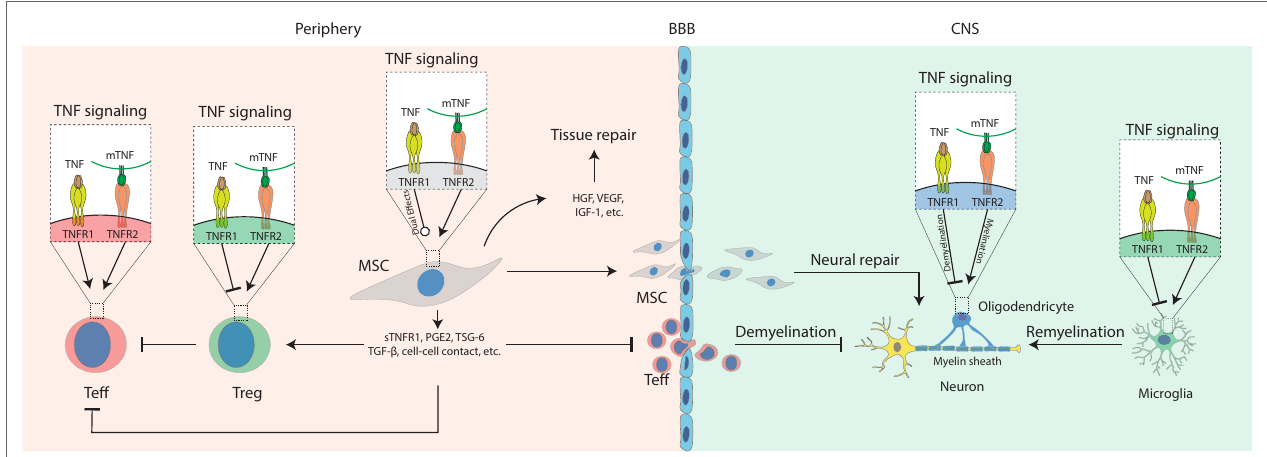
FiGURe 1 | Schematic diagram for the role of tumor necrosis factor (TNF) signaling in mesenchymal stem cell (MSC)-based therapy on autoimmune and inflammatory diseases. Under inflammatory conditions, TNF binds TNFR1 to activate T effector (Teff) cells while impairing regulatory T cells (Tregs); mTNF mostly binds TNFR2 to activate Teff cells and also activate Tregs to mediate their immunosuppressive effects in the periphery. In the central nervous system (CNS), TNFR1 signaling induces cytotoxic effects on oligodendrocytes resulting in neural demyelination and activates microglia to produce pro-inflammatory molecules such as TNF. TNFR2 signaling protects the survival of oligodendrocyte and microglia and promotes myelin clearance and remyelination mediated by microglia. In addition, TNFR1 or -R2 signaling can enhance the immunosuppressive effects of MSCs to alleviate autoimmune and inflammatory diseases. Compared to non-primed controls, TNF-primed MSC produce more soluble TNFR1 (sTNFR1), PGE2, TSG-6, and TGF- β , enhance Treg functions, neutralize TNF via sTNFR, prevent Teff cell infiltration into the CNS, release growth factors such as hepatocyte growth factor (HGF), insulin-like growth factor-1 (IGF-1), and VEGF to promote tissue or neural repair, infiltrate the CNS to mediate neural protection by regulating oligodendrocytes and microglia, suppressing Teff cells that have infiltrated the CNS.